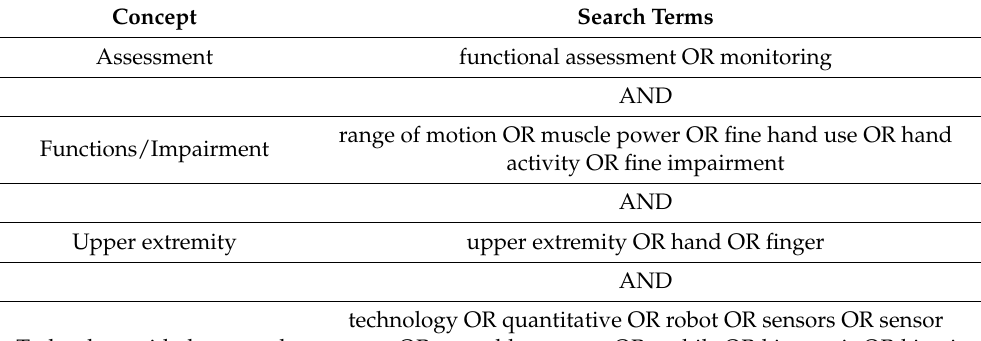
Table 1. Literature search